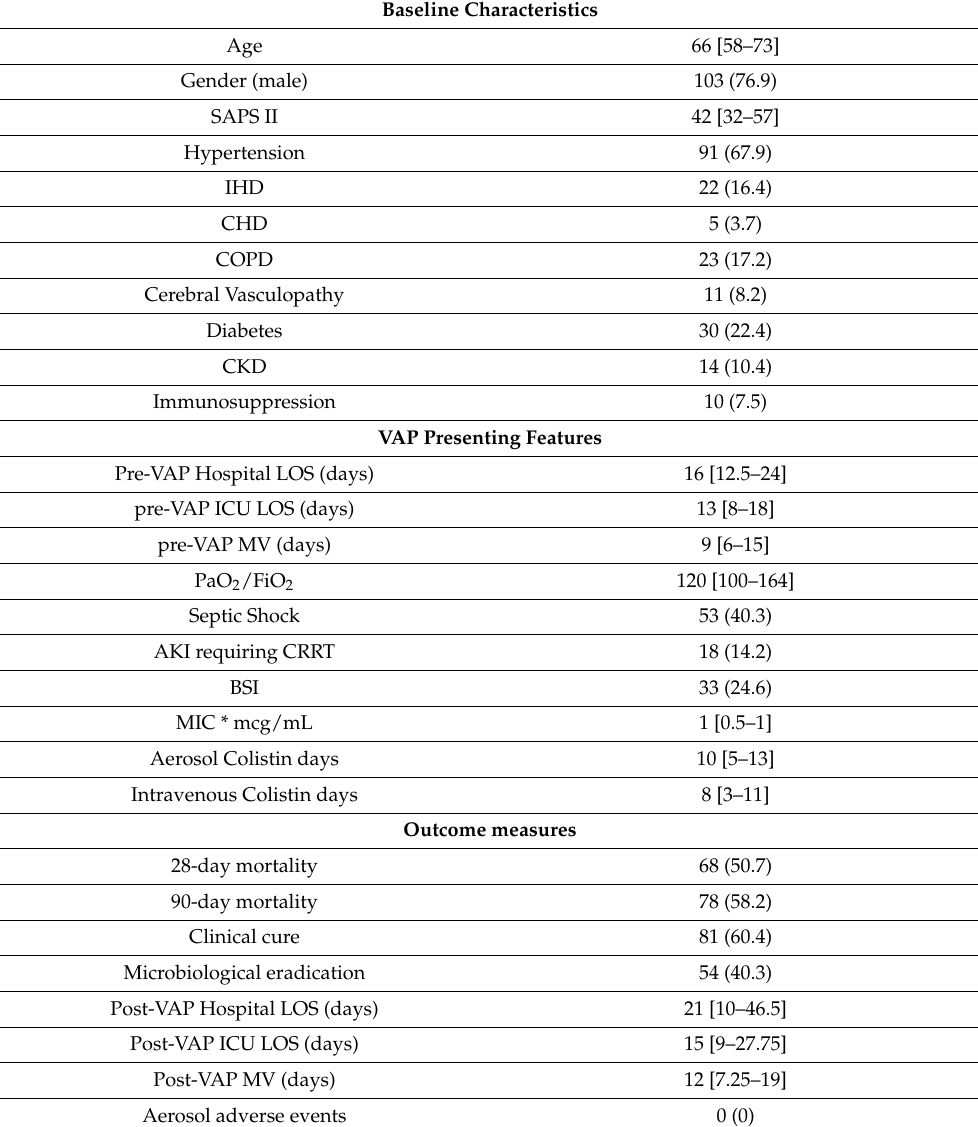
Table 1. Baseline characteristics, VAP presenting features, and outcomes of 134 enrolled